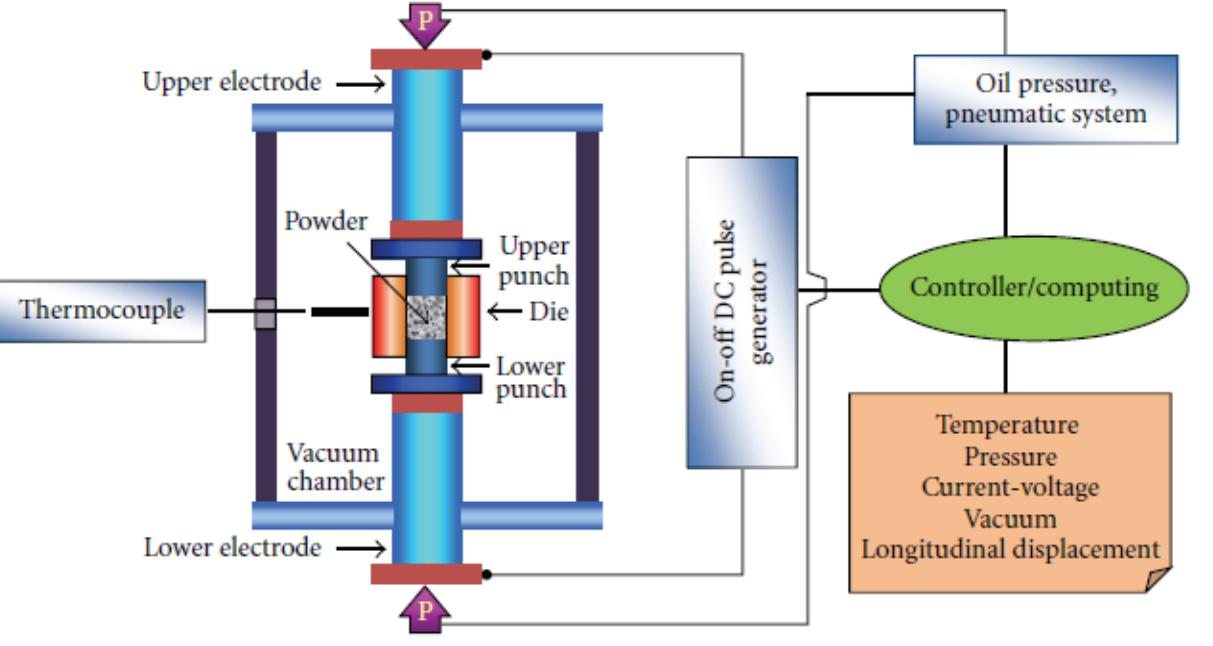
Figure 2. Schematic diagram of the SPS process [108].